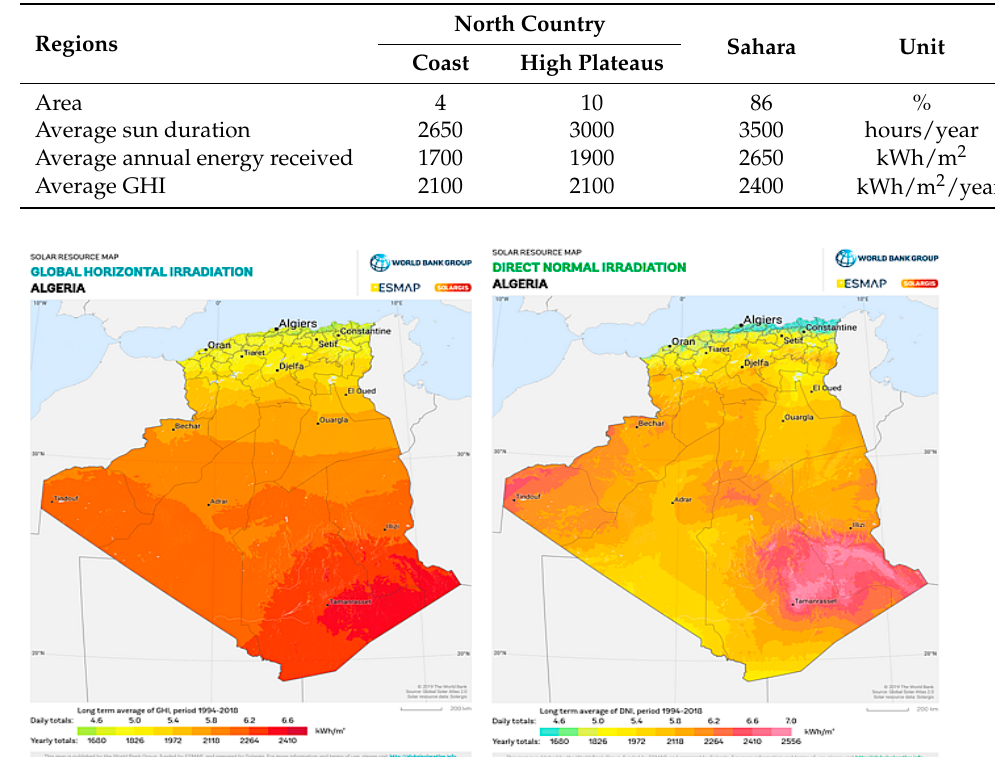
Figure 13. Global resource potential for CSP and PV.